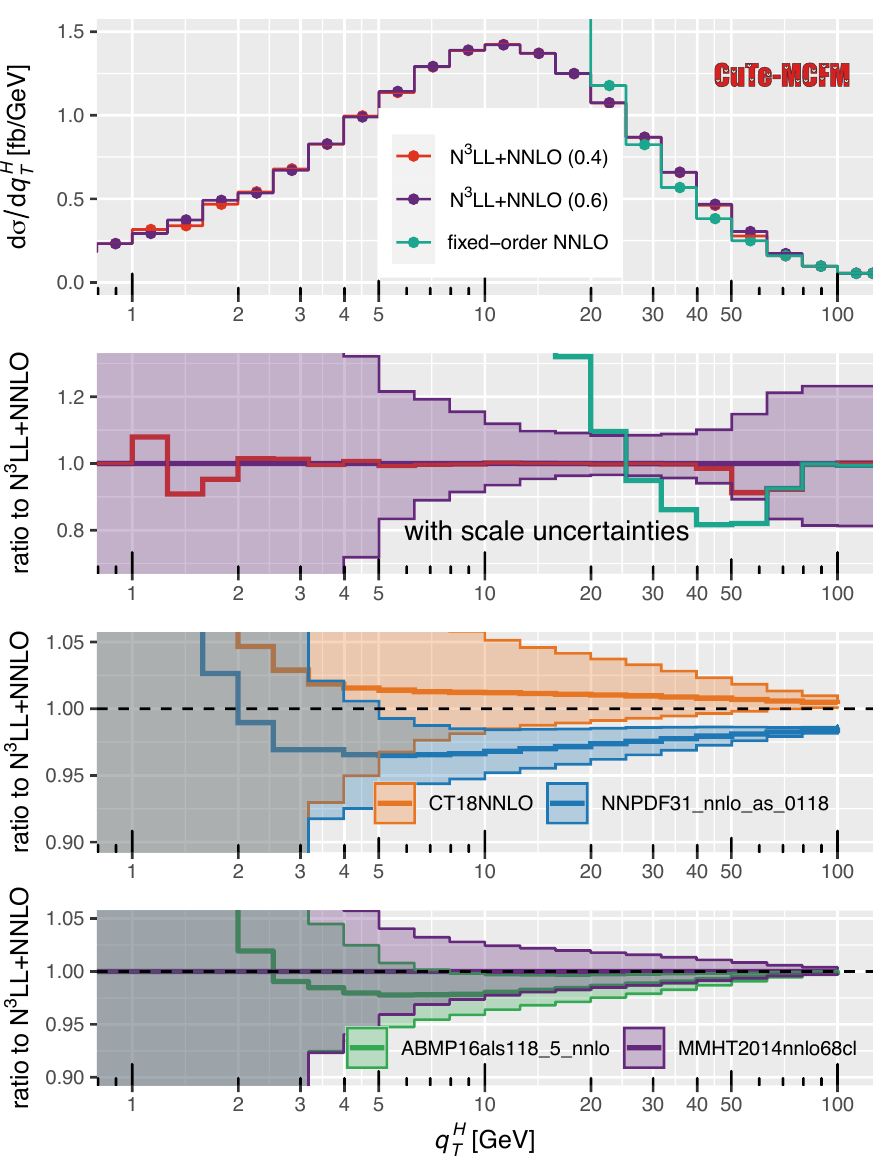
Figure 12. Higgs transverse-momentum distribution with fiducial cuts as in table 3. The second panel shows the effect of a different transition function and scale uncertainties, while the bottom panels show PDF uncertainties for different